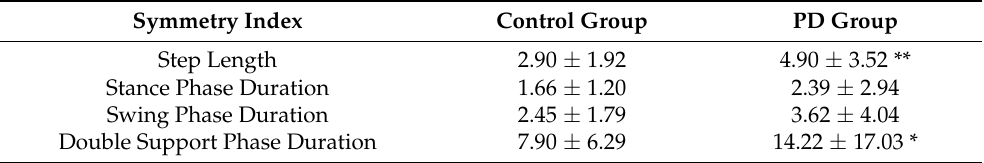
Table 3. SI parameters of gait. Stance, swing and double support phases are expressed as percentage of the gait cycle duration. Values are expressed as mean ± SD.